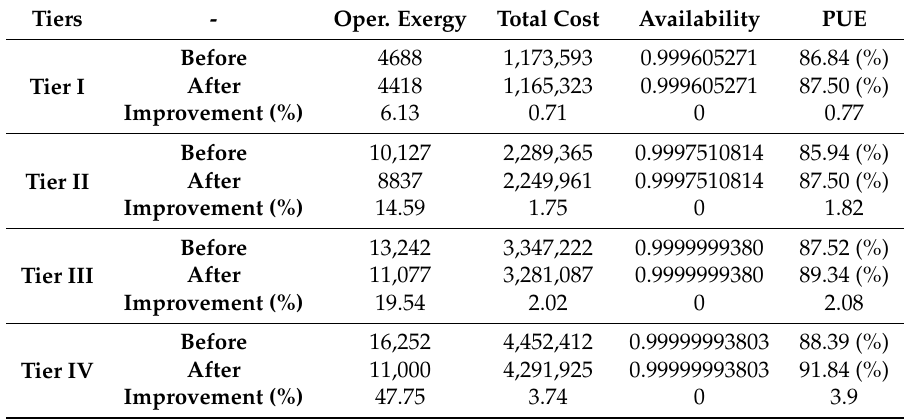
Table 3. Results of PLDA-D execution with improvement in %. Operational Exergy, Total Cost; Availability and